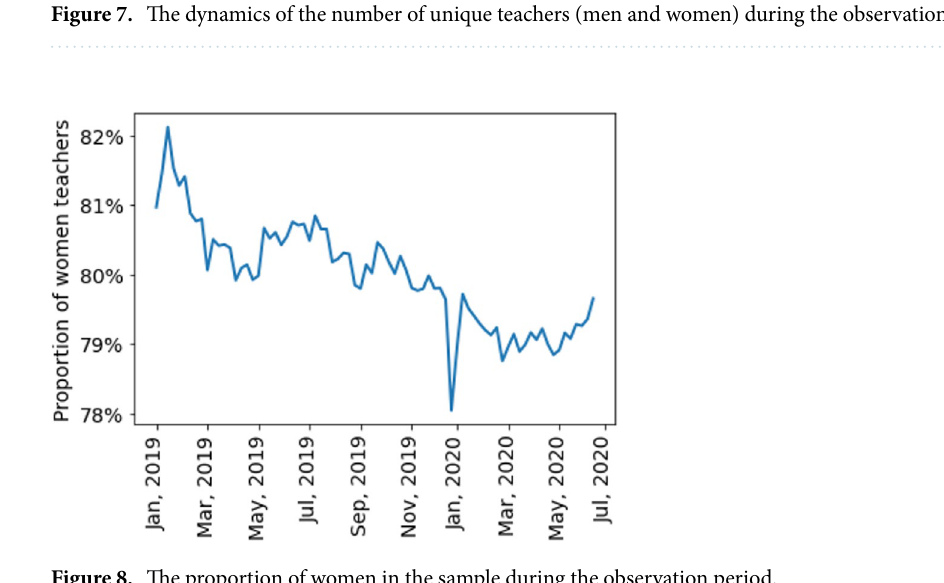
Figure 8. The proportion of women in the sample during the observation